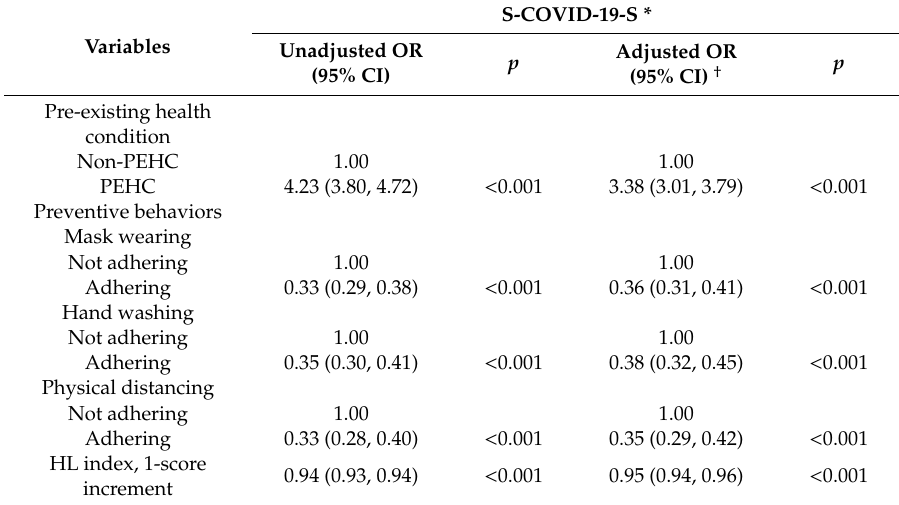
Table 2. Associations of pre-existing health conditions, preventive behaviors, and health literacy with having S-COVID-19-S ( N =